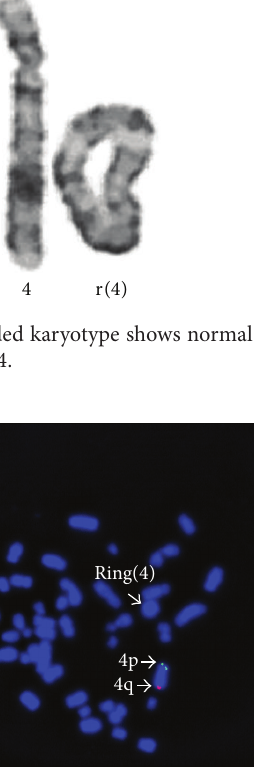
Figure 2: FISH study using a chromosome 4p specific subtelomeric probe (green signal) and a chromosome 4q specific subtelomeric probe (red signal) shows that subtelomeric 4p and 4q are deleted in ring chromosome 4.